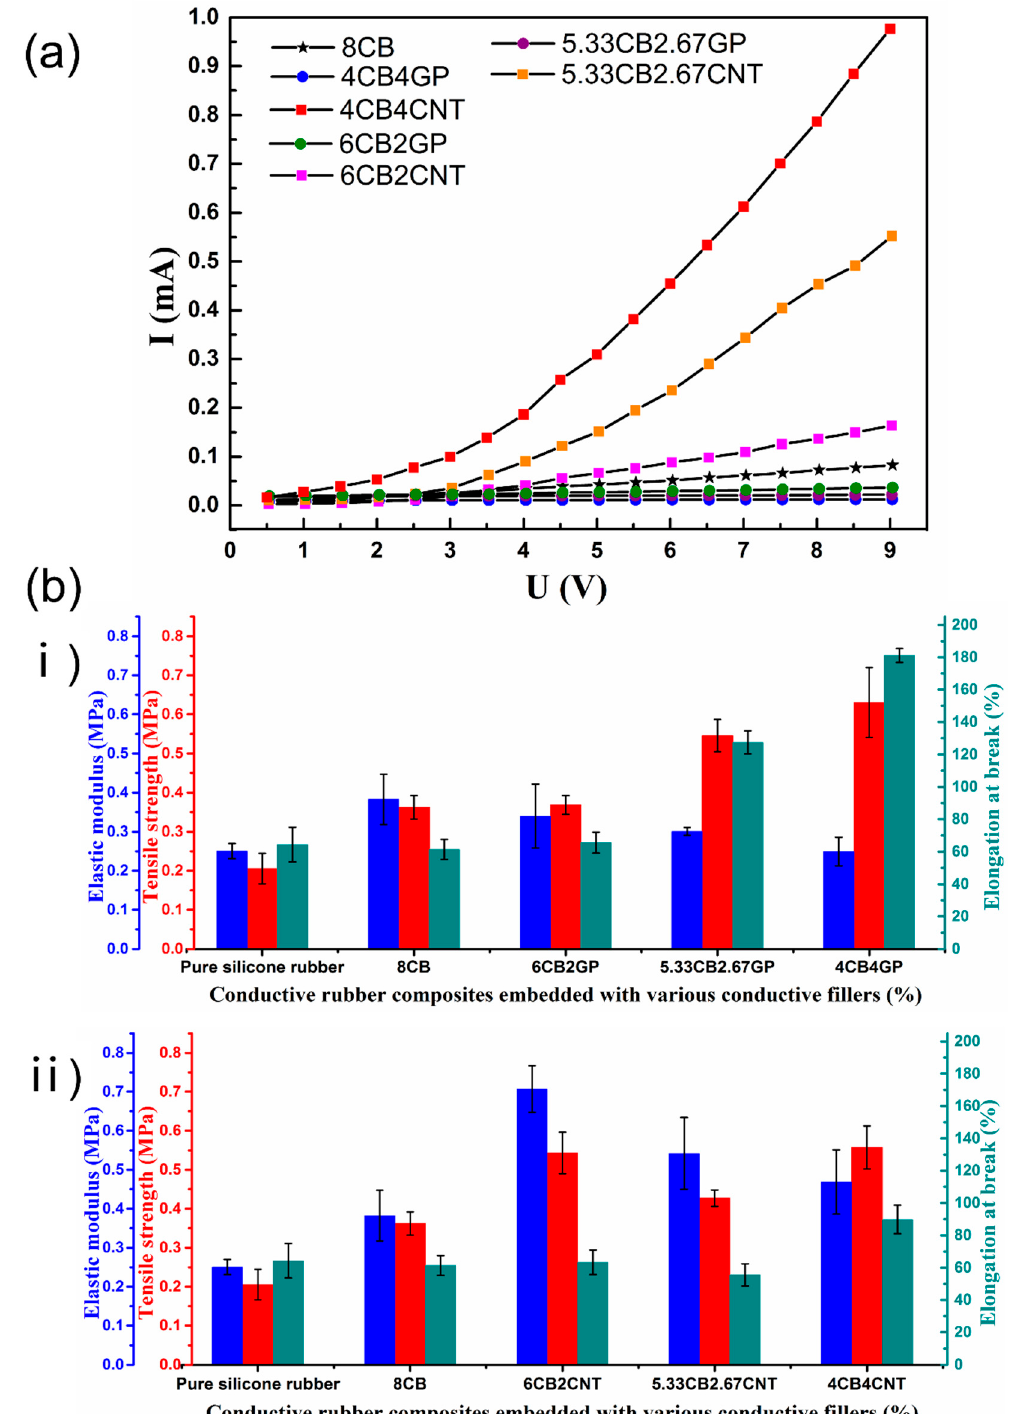
Figure 3. ( a ) Volt-ampere characteristics of the conductive rubber composites embedded with various conductive fillers, and ( b ) mechanical properties including the elastic modulus, tensile strength, and elongation at break of the conductive rubber composites embedded with CB/GP (i) and CB/CNT (ii).